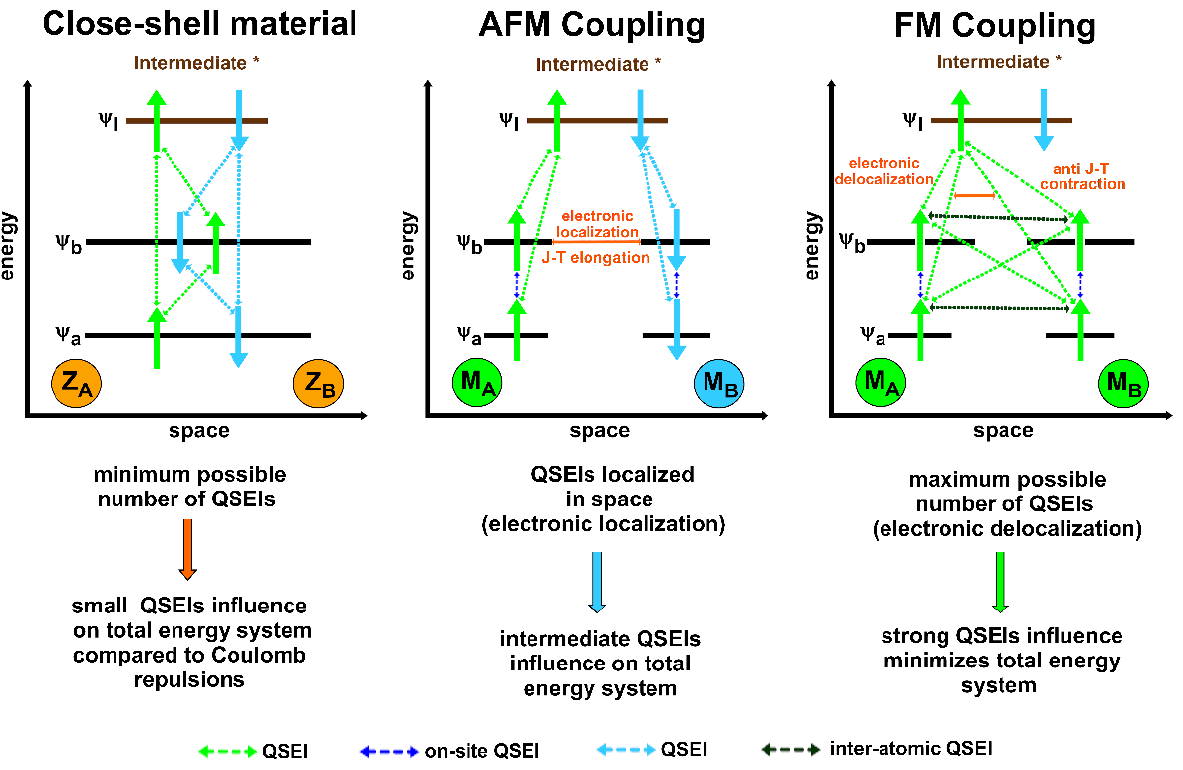
Figure 15. Simplified energy/space plots showing quantum spin exchange interactions (QSEIs) of catalysts and intermediates with a closed-shell ground state (left) and with predominant AFM (center) or FM (right) couplings. The model is strictly limited to a spin orbital ψ I , mostly localized in an intermediate of the catalytic process, and to the highest energy levels of the catalysts, namely ψ a and ψ b . QSEIs are displayed with colored dotted arrows [19]. Adapted with permission from Biz, C.; Fianchini, M.; Gracia, J. Strongly Correlated Electrons in Catalysis: Focus on Quantum